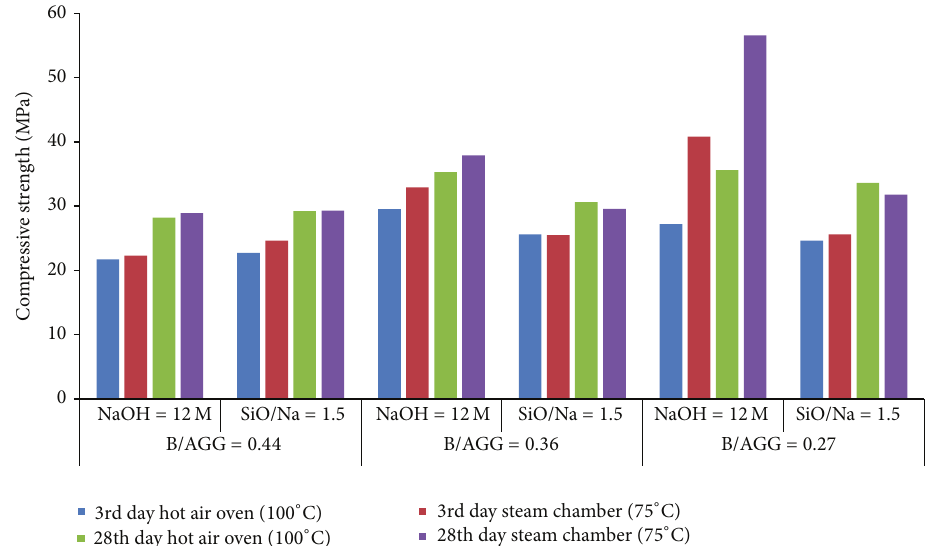
Figure 6: Compressive strength of various geopolymer concrete mixes tested.